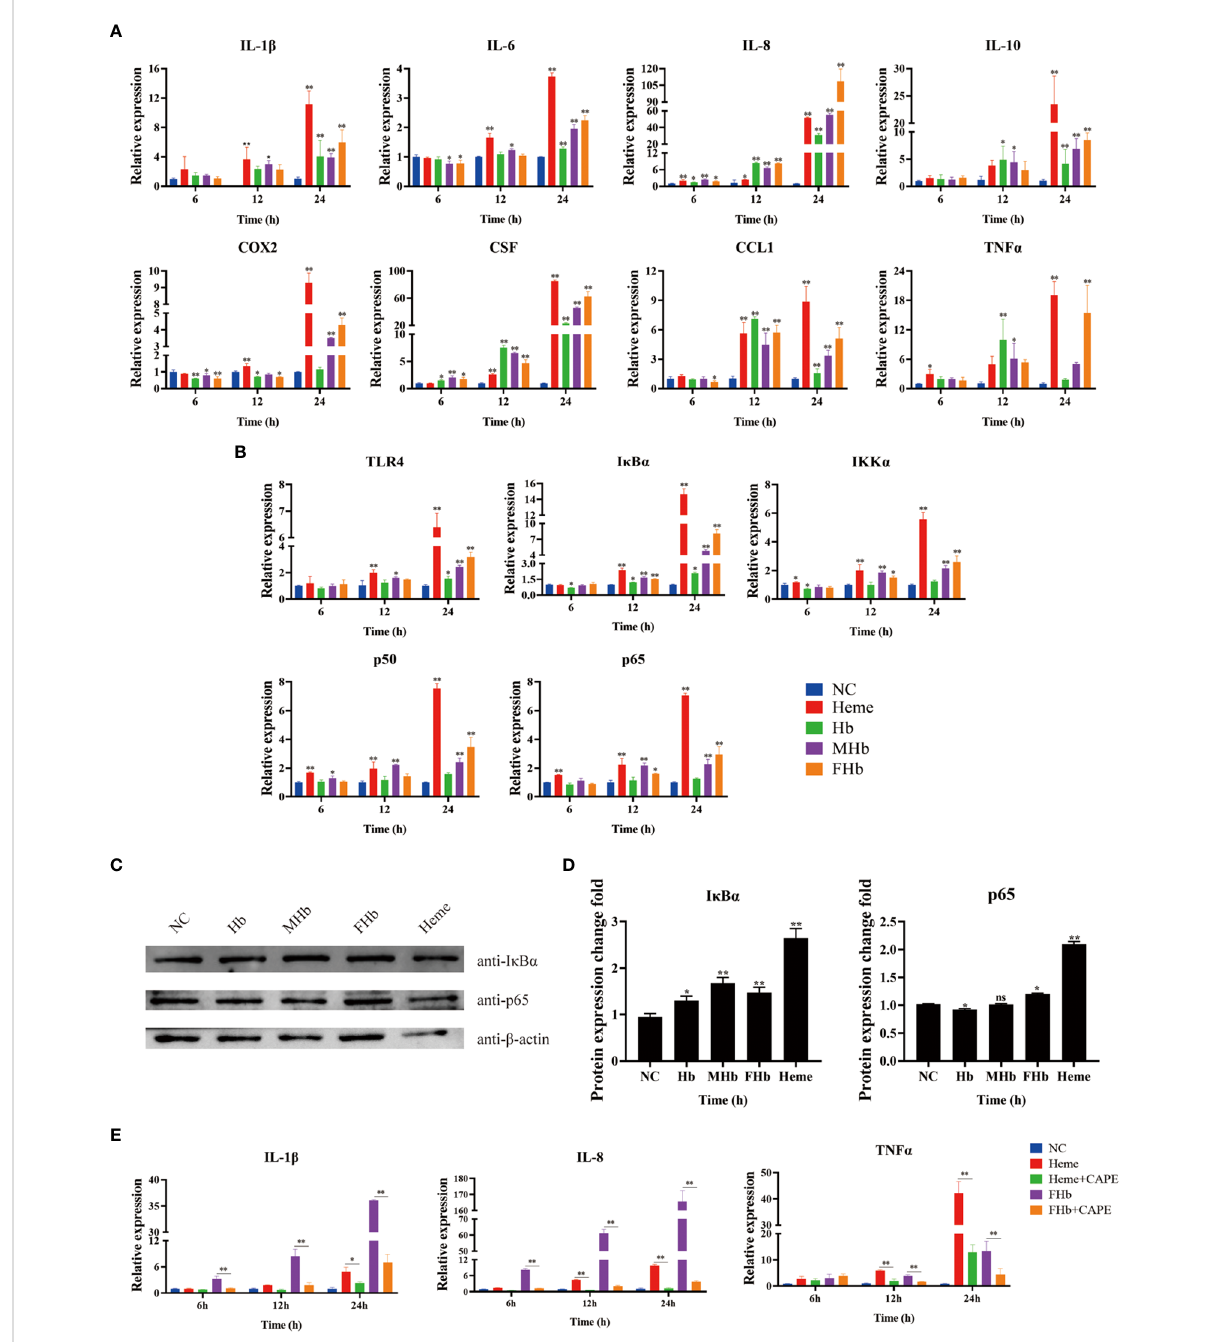
FIGURE 5 Hb, MHb and FHb modulated in fl ammation through NF- k B signaling pathway. (A, B) The qRT-PCR was used to detected the differential expression levels of mRNA including IL-1 b , IL-6, IL-8, IL-10, COX2, CSF, CCL1, TNF a (A) and TLR4, IKK a , I k B a , P50,P65 (B) in L8824 cells infected with heme and different Hb for 6, 12 and 24 h respectively. (C, D) After L8824 cells were infected with heme and different Hb for 12 h, the protein expression levels of I k B a and p65 were detected by WB, and gray scale analysis was performed by image J (E) . The expression level of mRNA of IL-1 b , IL-8 and TNF a were detected after L8824 cells were infected with FerrylHb and Heme with caffeic acid phenethyl ester (CAPE, 25 m M) for 6, 12 and 24 h, respectively. The data were the mean values of three independent experiments, expressed as mean ± SEM (*P < 0.05, **P <